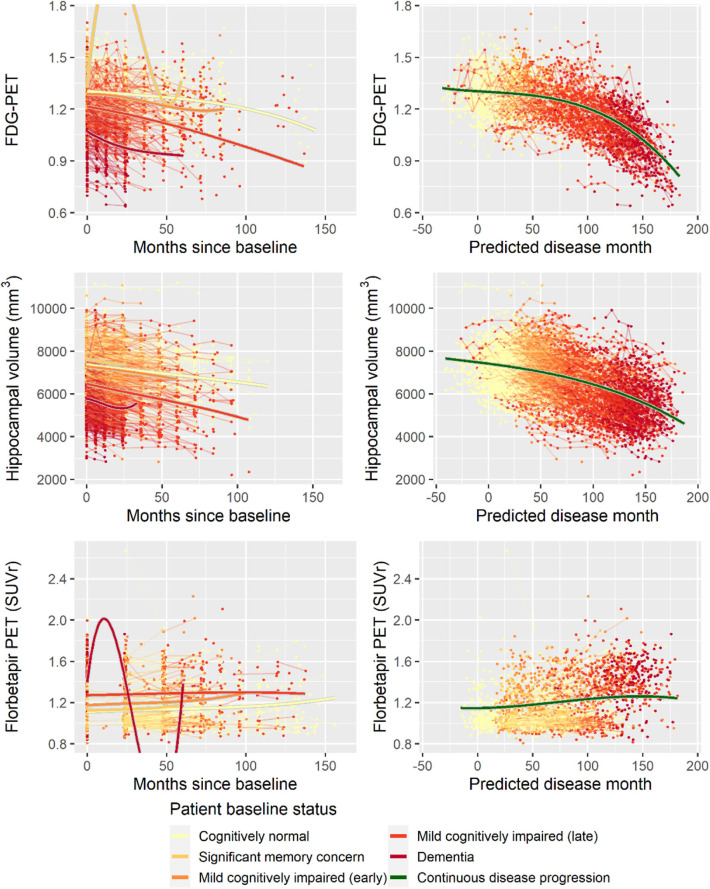
Data and estimated biomarker trajectories for FDG-PET, hippocampal volume (MRI), and florbetapir PET. Left column shows results when allowing different trajectories for the five baseline groups; right column shows the results when requiring a single trajectory over predicted disease time. Note that the oscillations for the significant memory concern and dementia groups on FDG-PET and florbetapir PET, respectively, occur in time periods where no data were collected for these groups.